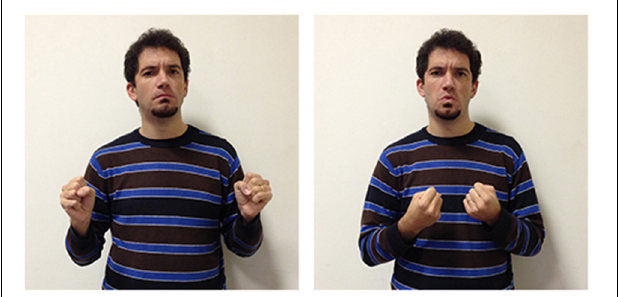
FIGURE 9 | LIS sign IMPOSSIBLE H - fff . FIGURE 10 | LIS sign IMPOSSIBLE AAA .